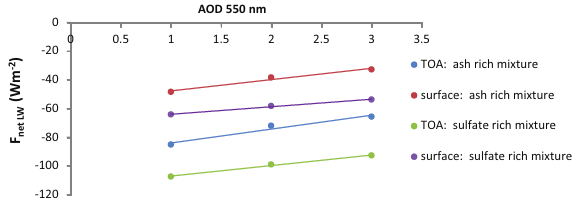
Fig. 13. The relationship between net LW flux and AOD(550nm) at an AOD range of 1–3 for two aerosol mixtures at the TOA and surface. The R 2 regressions for all lines are greater than